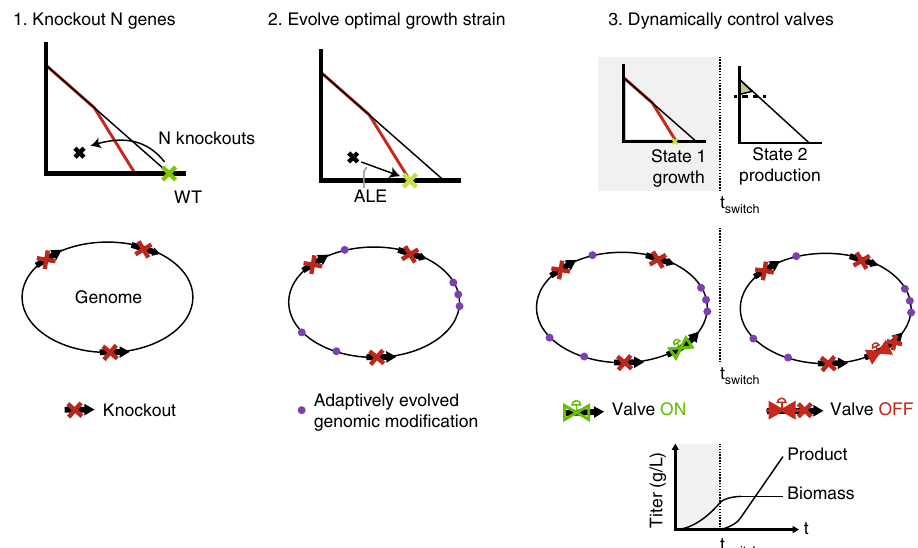
Fig. 2 Implementation considerations for MoVE strategies. First, a set of static knockouts can be made using canonical genetic engineering techniques. Second, if the growth rate has suffered due to sub-optimality, the strain can be adaptively evolved to maximize growth rate, accumulating genomic modi fi cations. Finally, genetic circuitry can be applied to effect a switch by eliminating fl ux through target valves, and achieving at least the minimum speci fi c target (e.g., product